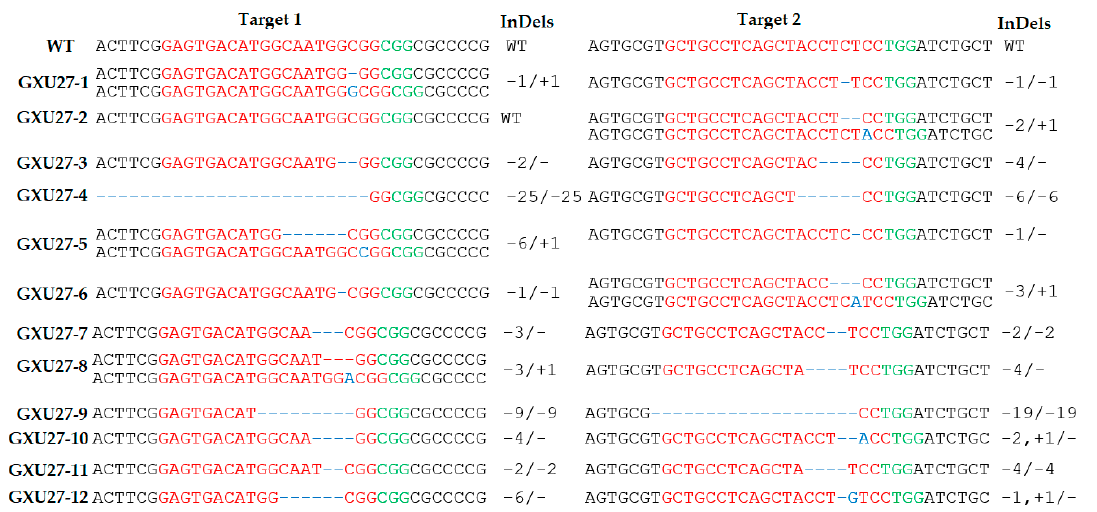
Figure 2. Sequence alignment of both target sites and information about deletions and insertions in all T 0 mutant lines. The targeted sequence is highlighted in red, and the protospacer adjacent motif (PAM) sequence in green. Deletions and insertions are represented by blue hyphens and uppercase letters, respectively.